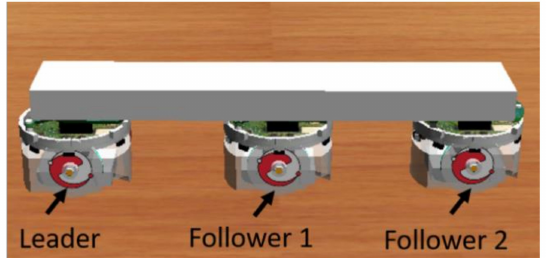
Figure 27. Cooperative load-carrying of three